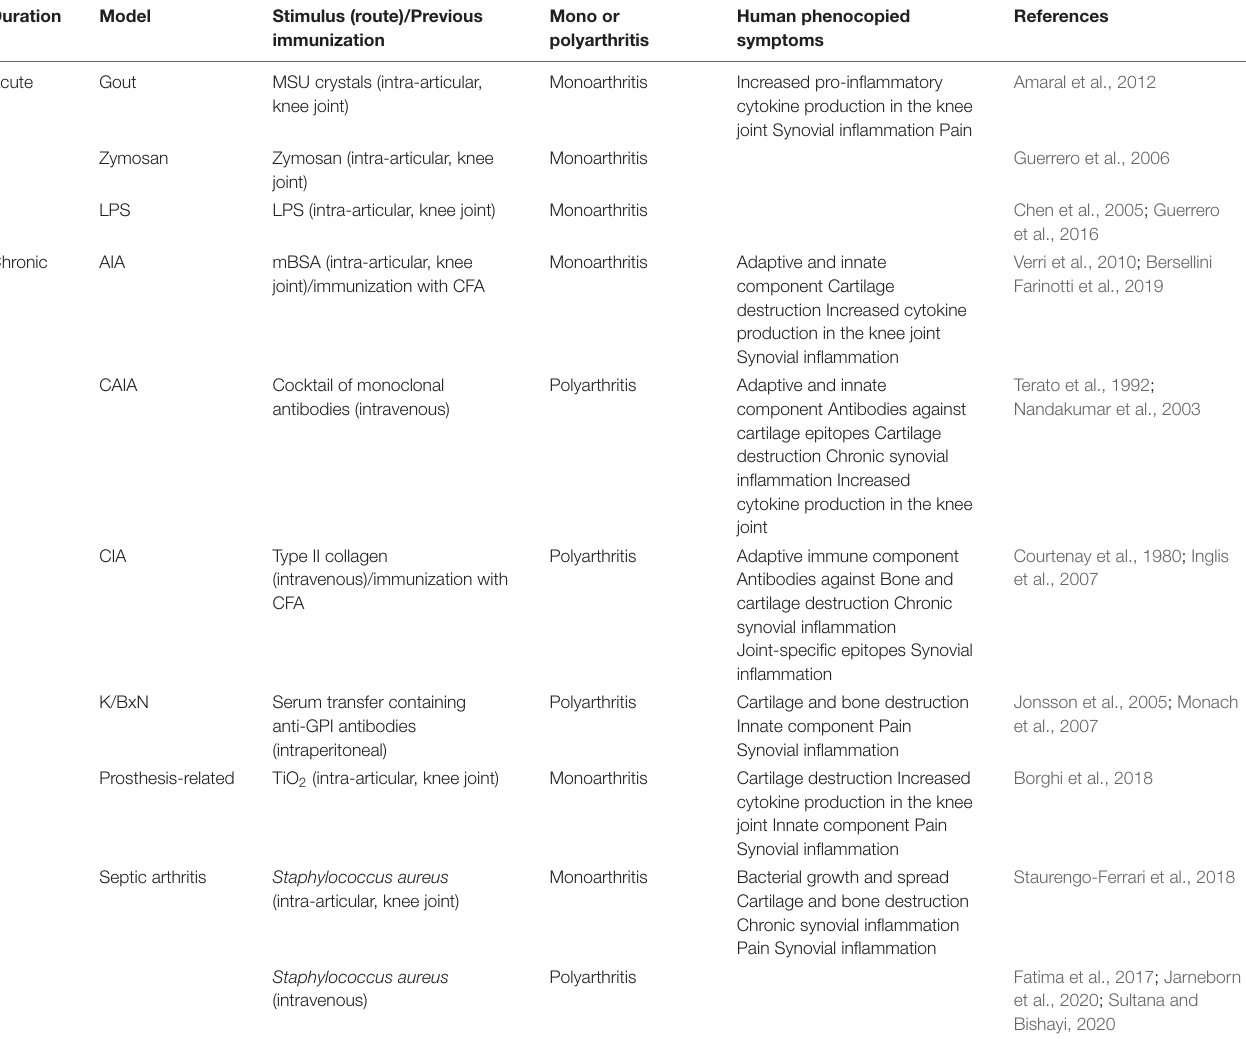
TABLE 3 | Animal models of